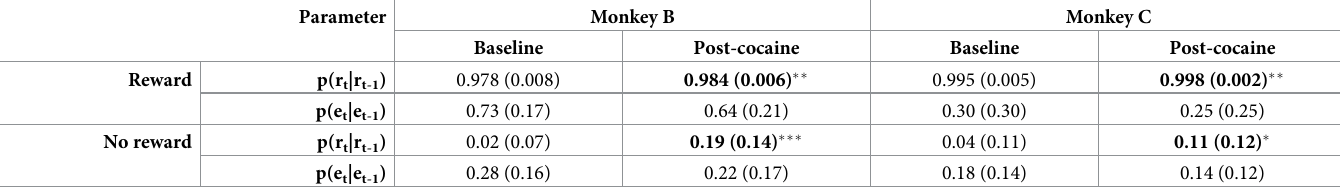
Table 1. Effects of cocaine on model parameters. Mean parameter estimate (standard deviation) across all models. p(e t ) = probability of exploration. p(r t ) = probability of rule. Bold: significant change in post-cocaine sessions, relative to baseline within each monkey: � p < 0.05, �� p < 0.005, ��� p < 0.0001, t-test (see Results for test